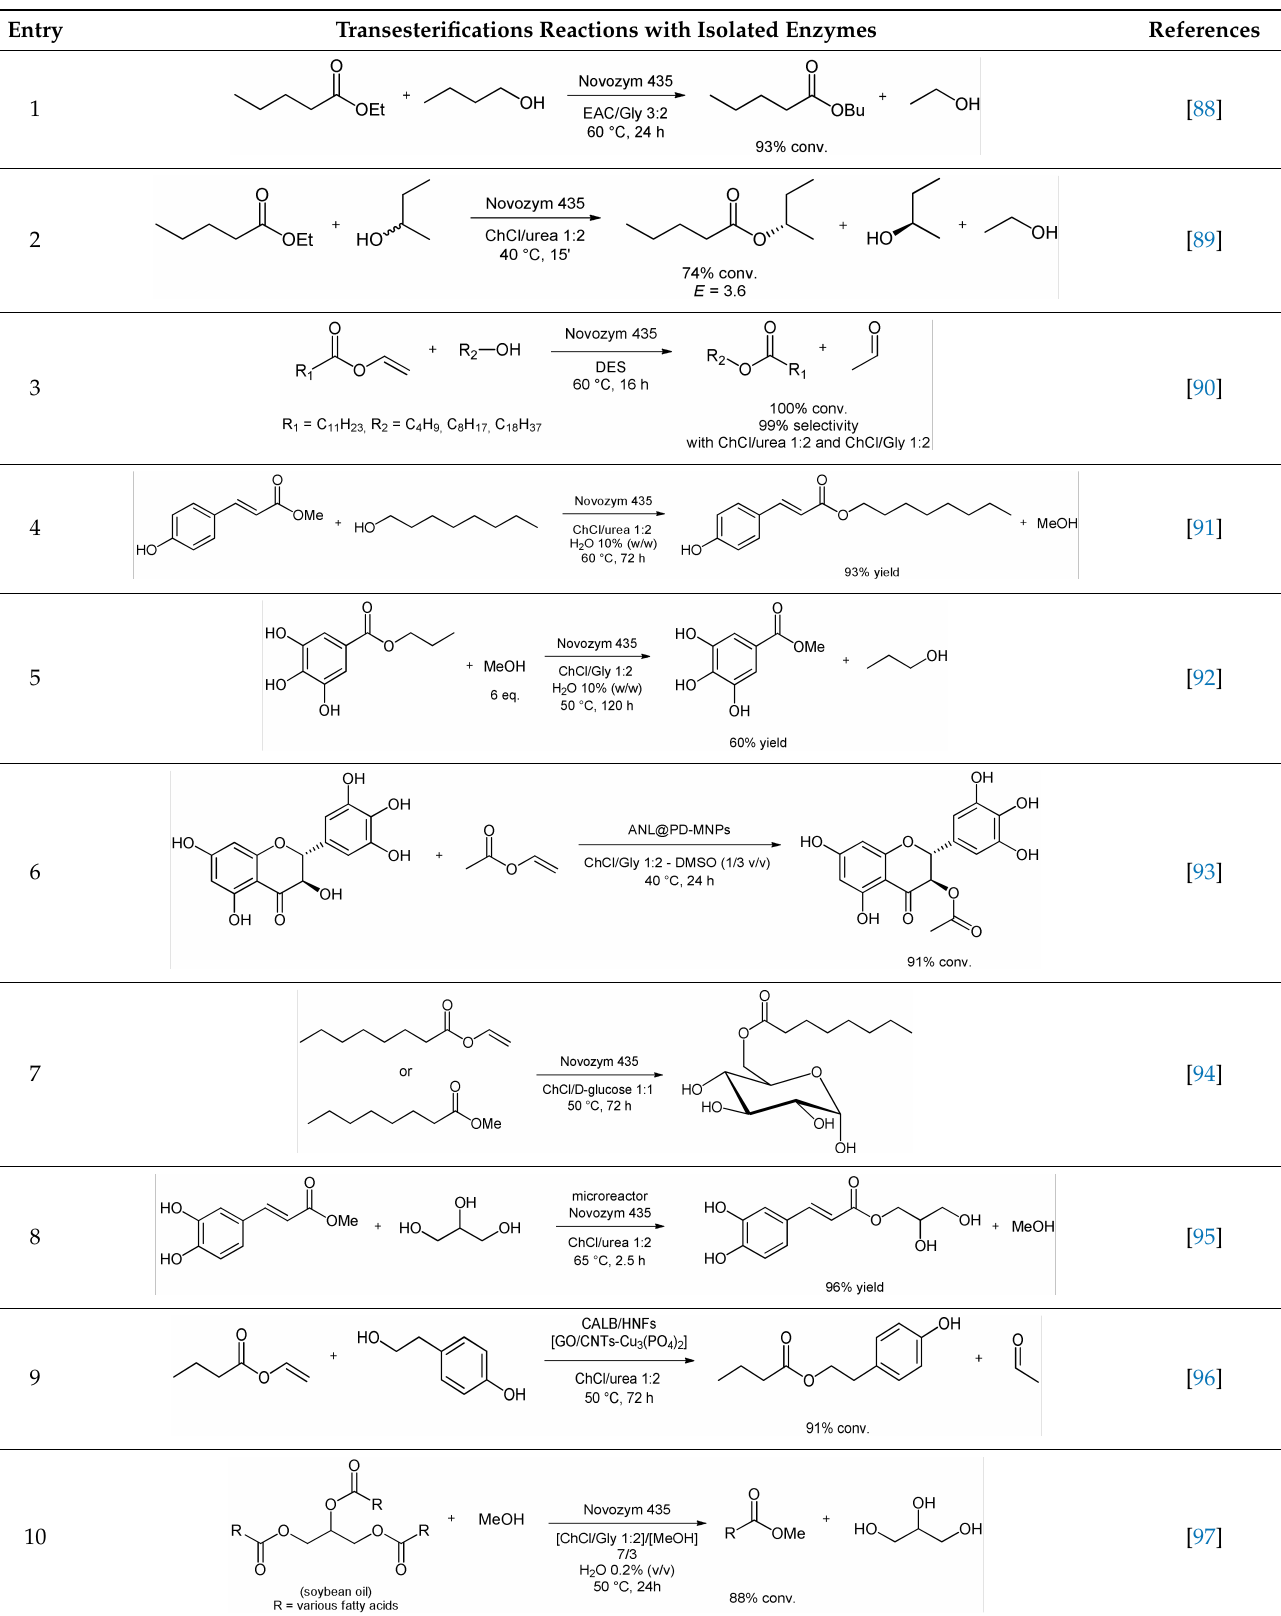
Table 8. Transesterifications reactions with isolated